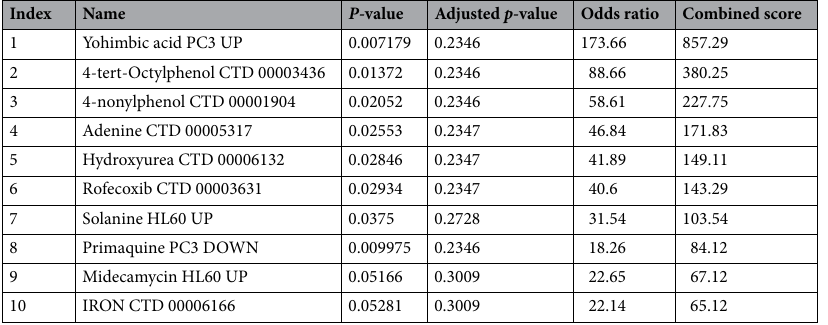
Table 2. Candidate drugs of DEGs in DSigDB